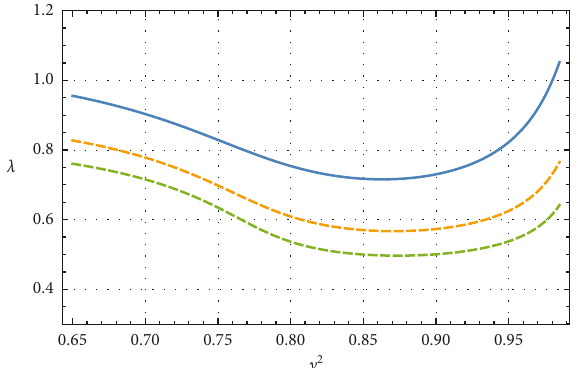
Figure 3: The curves for three values of the zero-temperature gap, , are shown; μ ∗ � 0 . 1 and E Δ 0 � 60 , 40, and 30meV, from top to bottom. for Δ 0